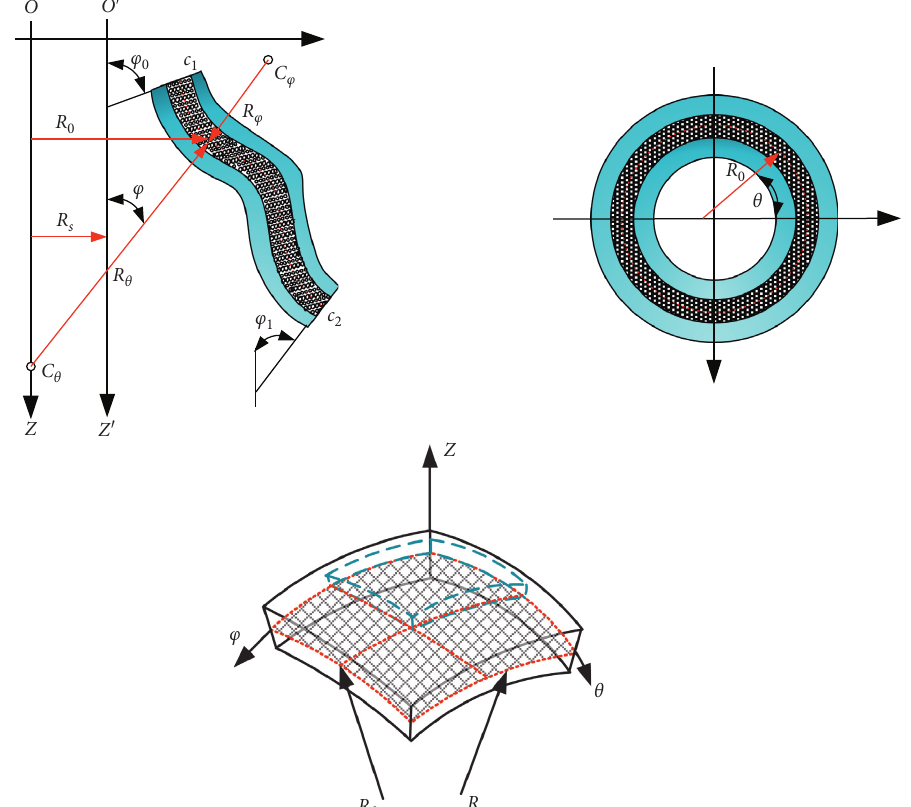
Figure 1: Geometric and reference system of a Sandwich FGP doubly curved structure.